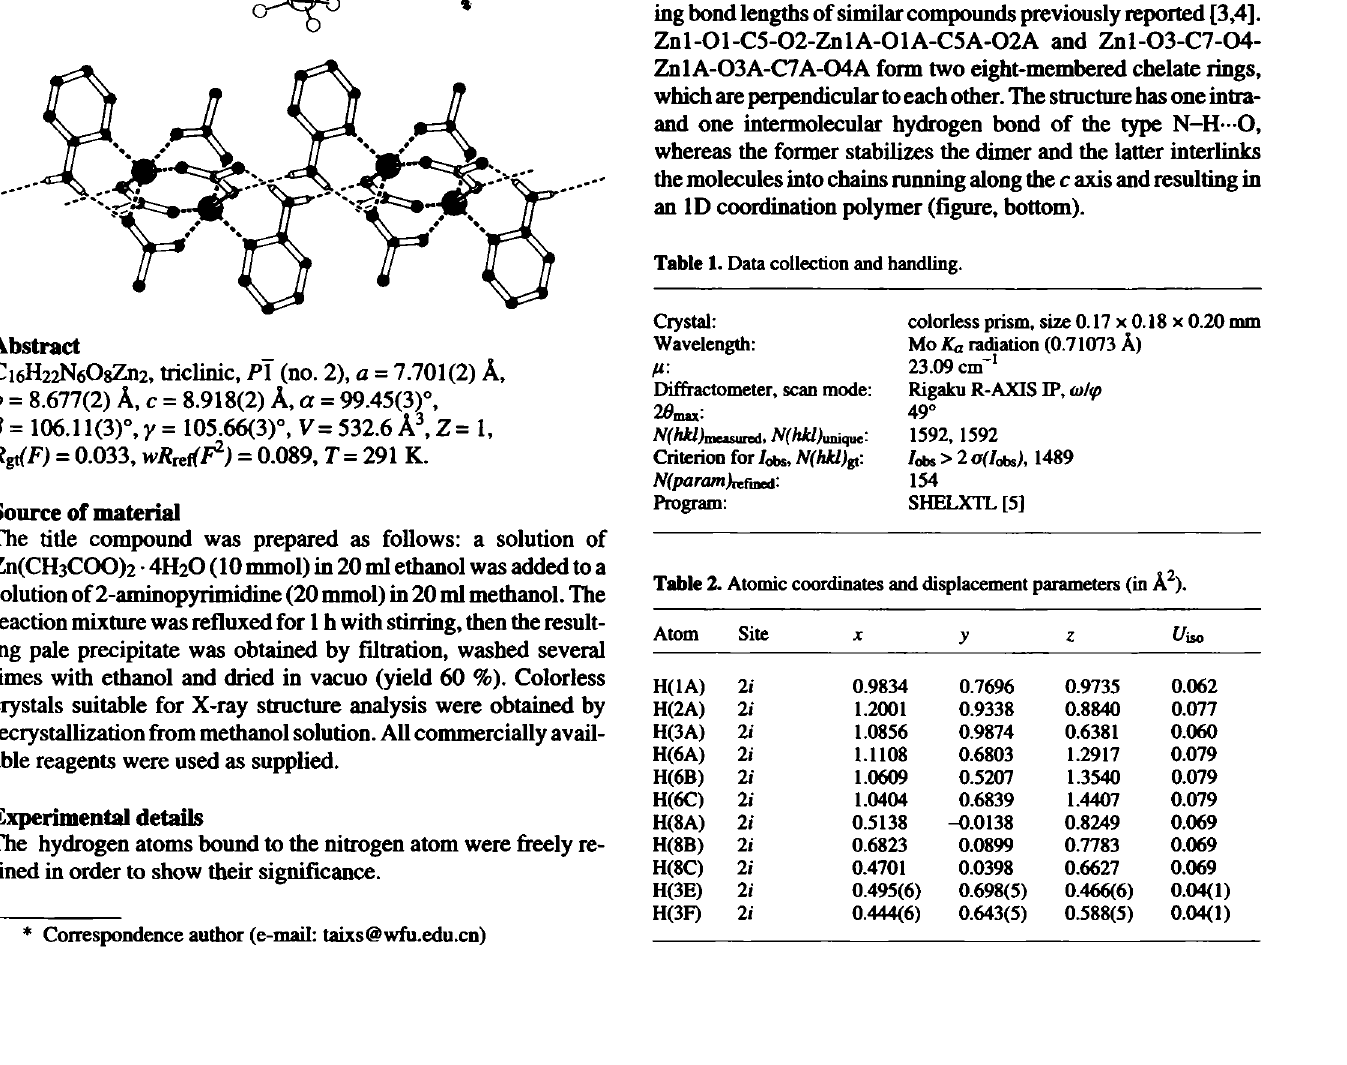
Table 1. Data collection and handling.